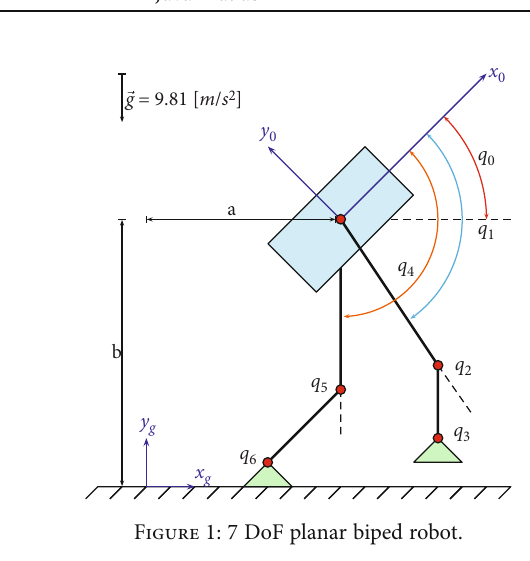
Figure 1: 7 DoF planar biped